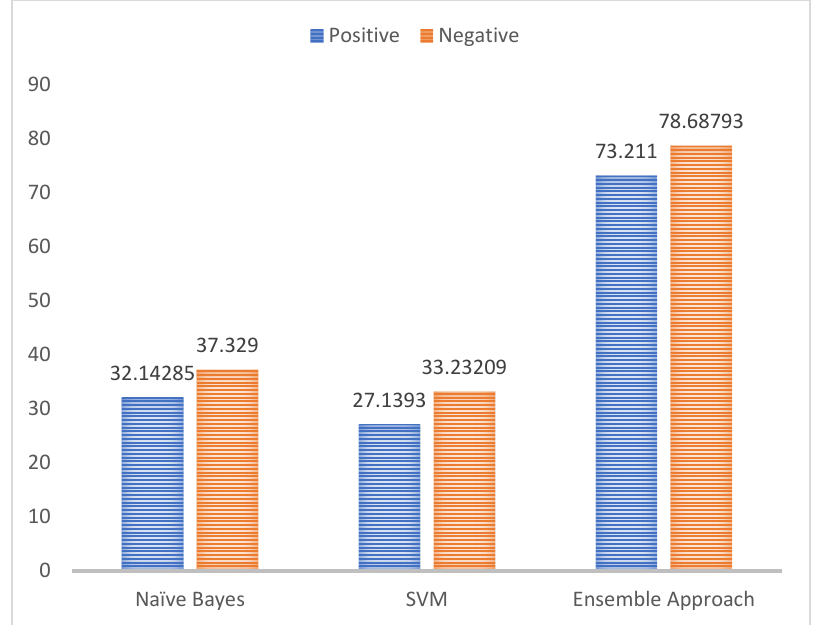
Figure 4. Analysis of data